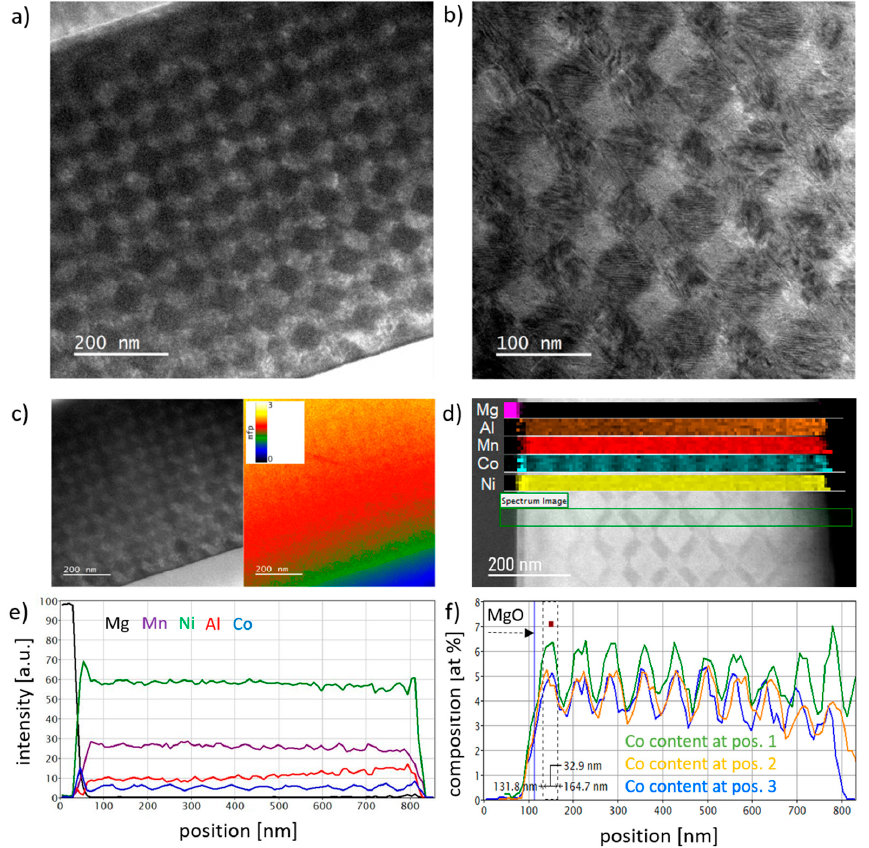
Figure 2. TEM images of a cross section show a 3D-checkerboard structure ( a , b ). ( c ) EFTEM thickness map. ( d ) STEM dark field image of the checkerboard sample with the overlaid EDX elemental mappings. The scanned area is marked by the green rectangle. ( e ) Corresponding line profiles of the elemental compositions. ( f ) EDX line profiles of the Co content extracted from EDX mappings measured on three different regions across the whole lamella. The layer modulation in the Co content is clearly visible.